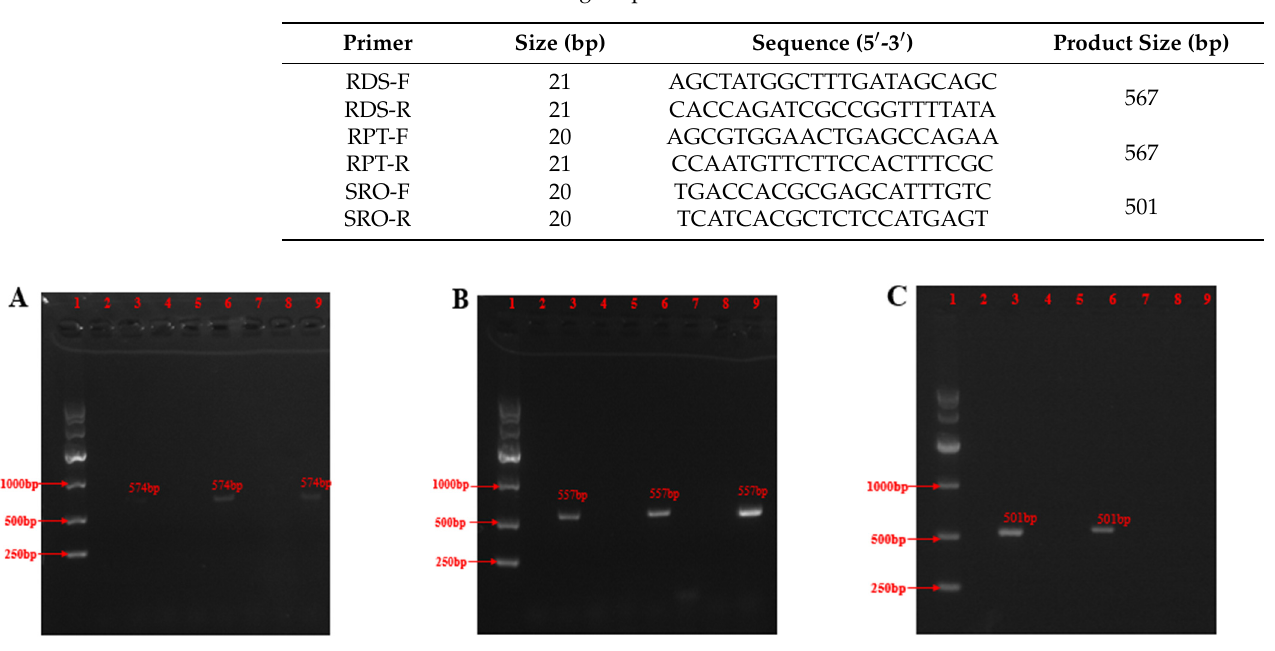
Figure 1. PCR amplification of genes required for biosynthesis in different strains. ( A ) PCR amplifi- cation of the RDS gene in different strains. Lane 1, Marker; Lane 2, Water; Lane 3, OUCMDZ-1435; Lane 4, OUCMDZ-3597; Lane 5, OUCMDZ-4032; Lane 6, OUCMDZ-4014; Lane 7, OUCMDZ-5210; Lane 8, OUCMDZ-019; and Lane 9, OUCMDZ-4754. ( B ) PCR amplification of the RPT gene in different strains. ( C ) PCR amplification of the SRO gene in different strains.